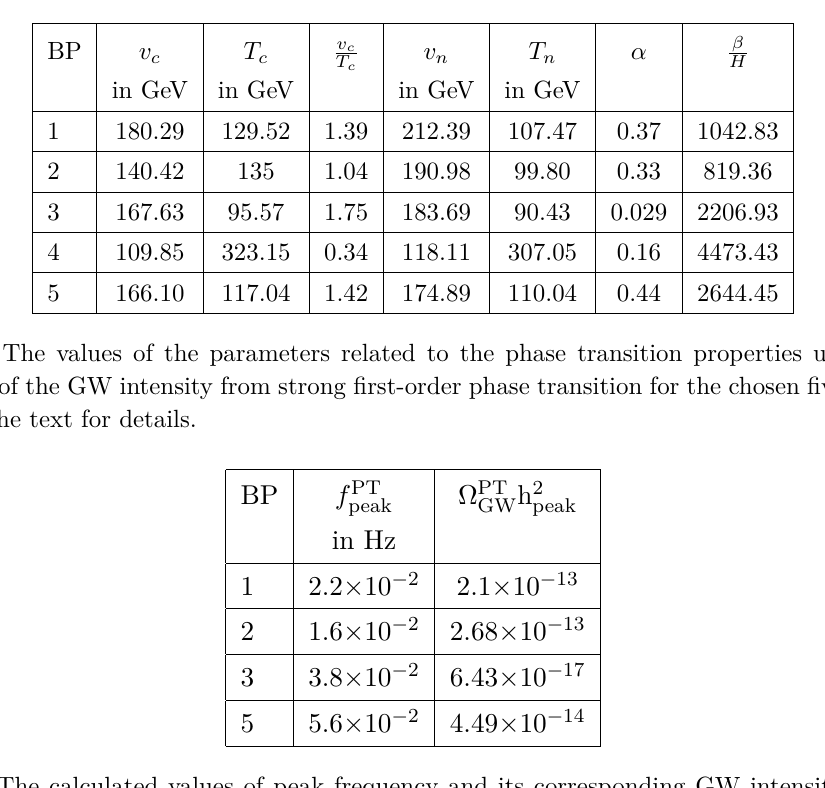
Table 5. The calculated values of peak frequency and its corresponding GW intensity from the contribution of strong first-order phase transition for the chosen BPs (BP 1, BP 2, BP 3 and BP 5). Note that we do not show the results for BP 4 since in the case of BP 4 the strong first-order phase transition condition is not satisfied ( v c /T c < 1 , table 4), as a result it is unable to produce